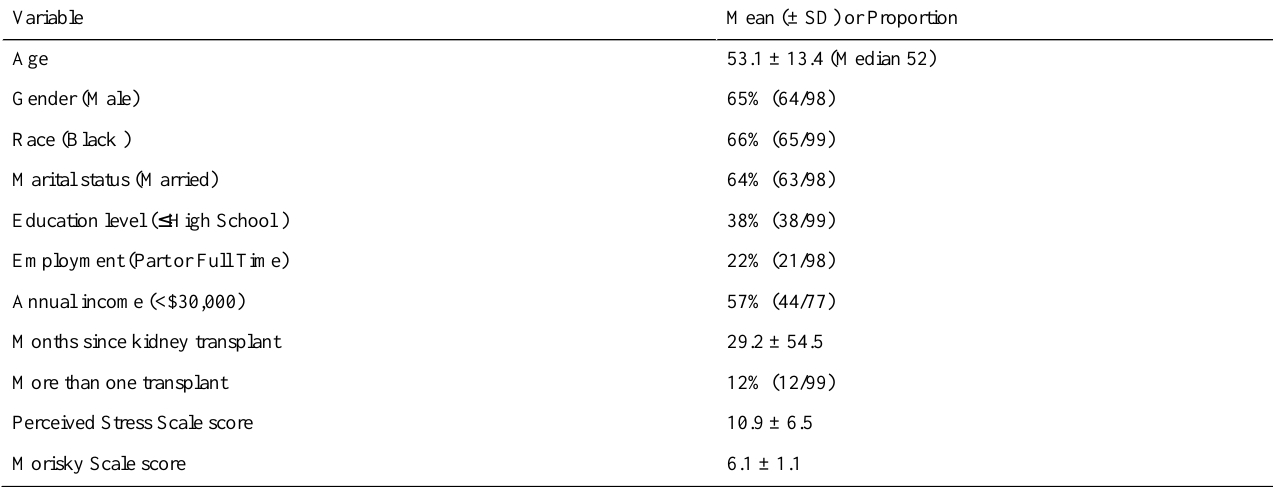
Table 1. Demographic and transplant related clinical characteristics of survey